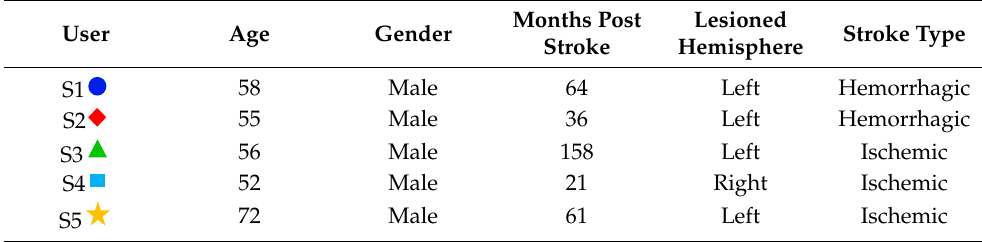
Table 1. Participants characteristics.